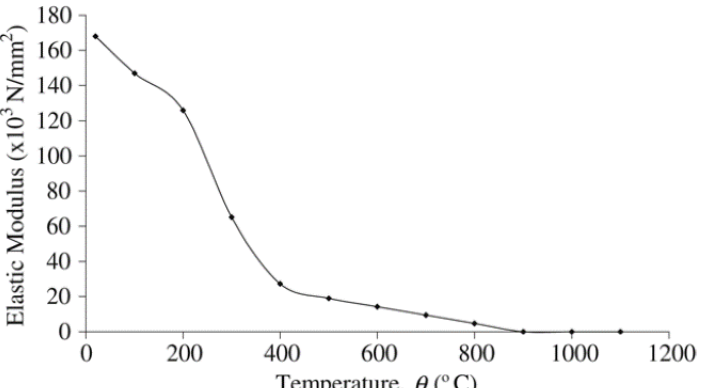
Figure 7. Modulusofelasticityofstructuralsteelatelevatedtemperatures, Figure 7. Modulus of elasticity of structural steel at elevated temperatures, EC3 British Standards Figure 7. Modulus of elasticity of structural steel at elevated temperatures, EC3 British Standards Figure 7. Modulus of elasticity of structural steel at elevated temperatures, EC3 British Standards Institution. Institution. Institution.